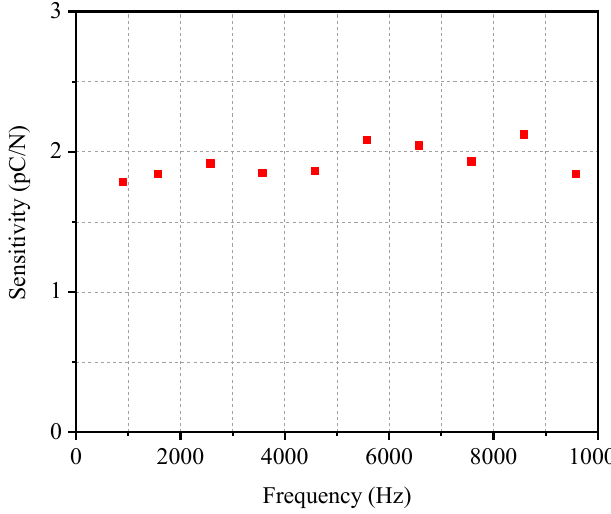
Figure 6. Calibration result for frequency response.